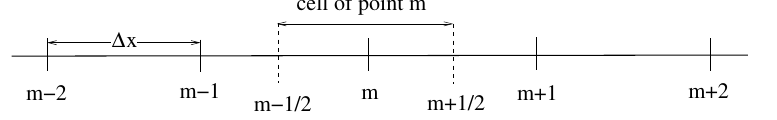
Figure A1. A part of a 1D computational